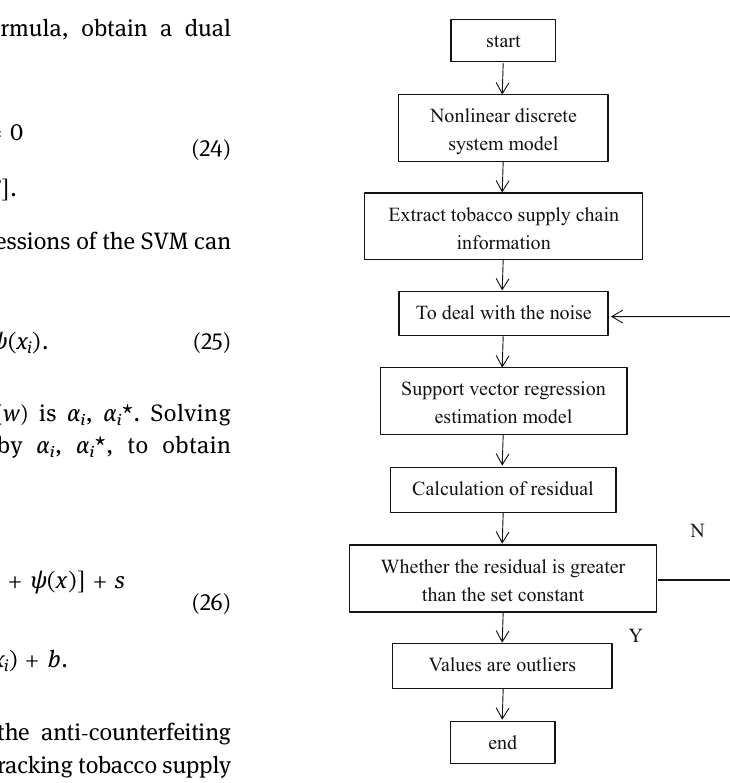
Figure 1: Detection fl ow